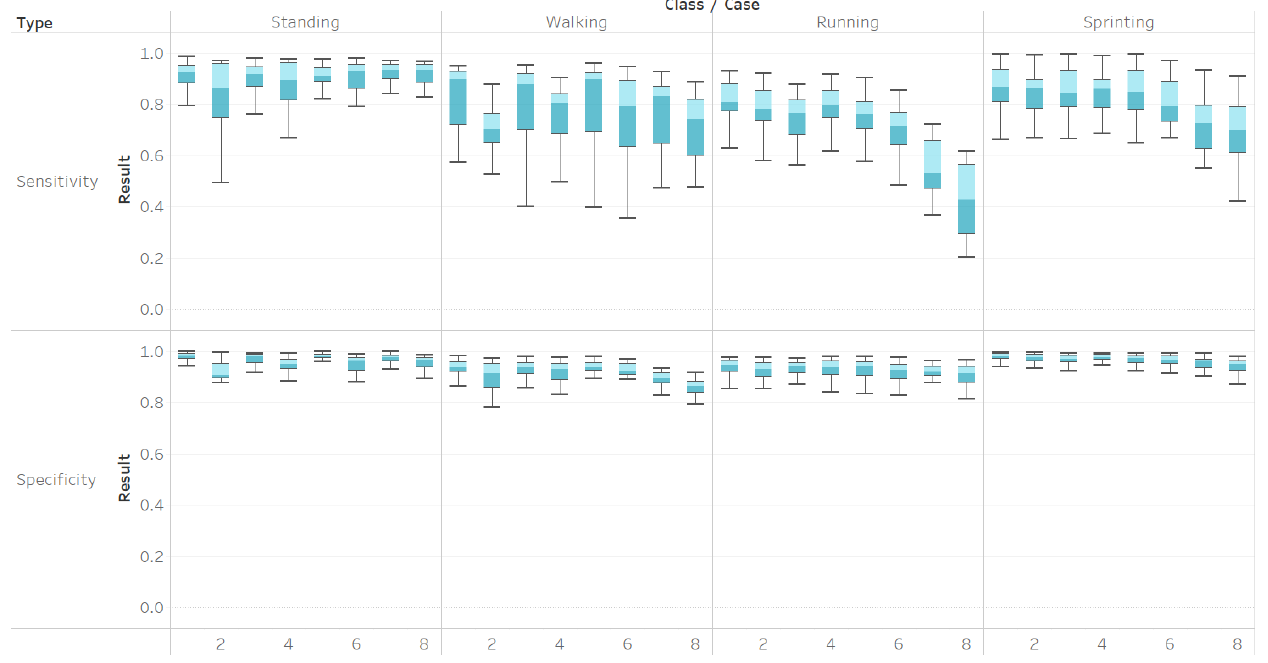
Figure 7. Sensitivities and specificities of each action per